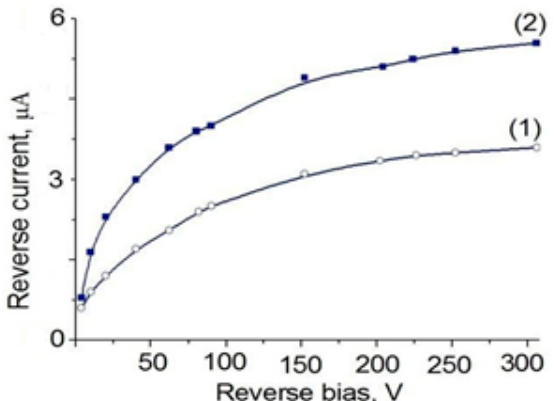
Figure 10. The inverse branch of I–V of the Si(Li) p-i-n structure, grown by the Czochralski process (line 1) and floating-zone method (line 2).